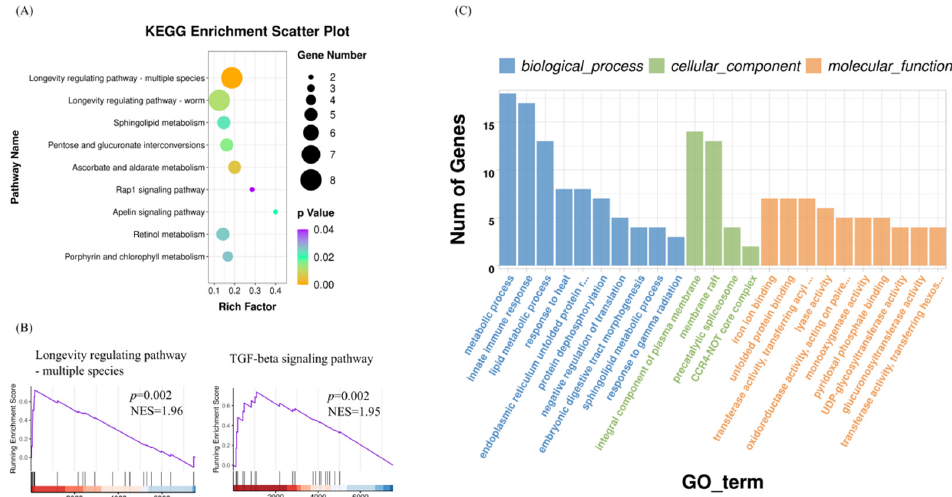
Figure 3. Significant KEGG pathways identified by enrichment analyses ( A ) and GSEA ( B ) ( p < 0.05, q < 0.25) in C. elegans treated with astaxanthin. Rich factor is the ratio of the DEG number in each group to the total number of genes identified in the KEGG analyses. Normalized enrichment score (NES) reflects the enrichment of a pathway in the ranked gene list after correction for the size of the pathway. ( C ) Significant GO terms of DEGs found by enrichment analyses in C. elegans treated with astaxanthin.